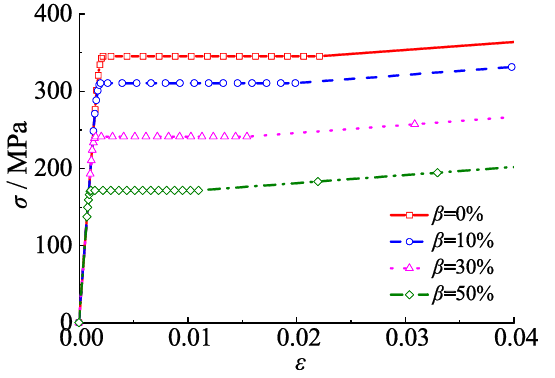
Figure 3. Stress–strain curve of steel tube under alternation of sulfate corrosion and freeze-thaw cycles.